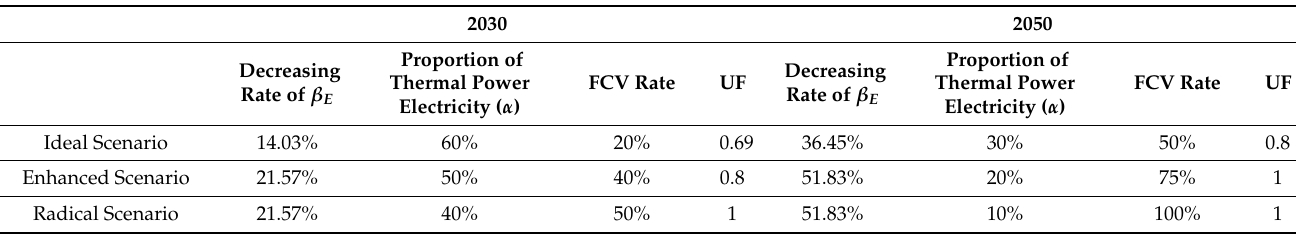
Table 2. Design of